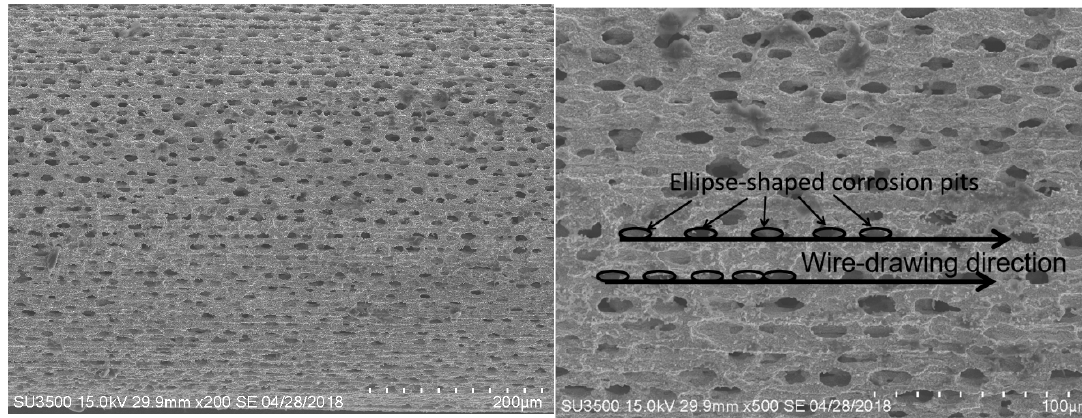
Figure 4. Surface morphology of IrRh25 after 60 h of high-temperature oxidation. Materials 2019 , 12 , x REVIEW